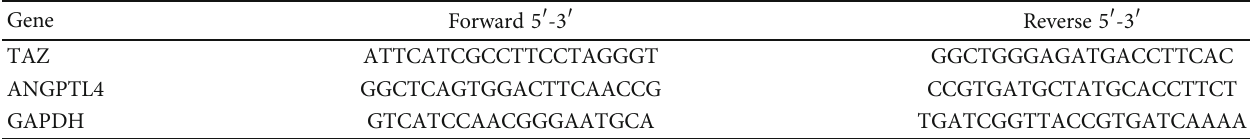
Table 1: Primer sequences.